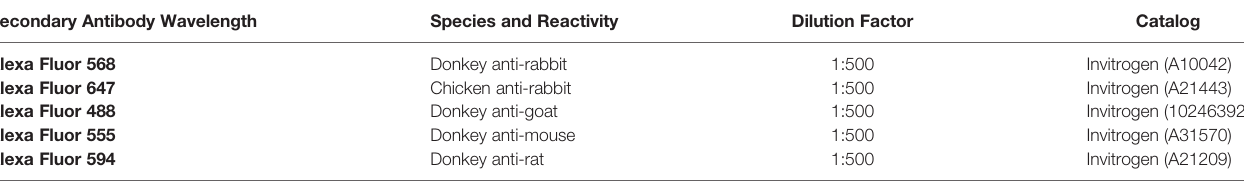
TABLE 2 | Secondary antibodies